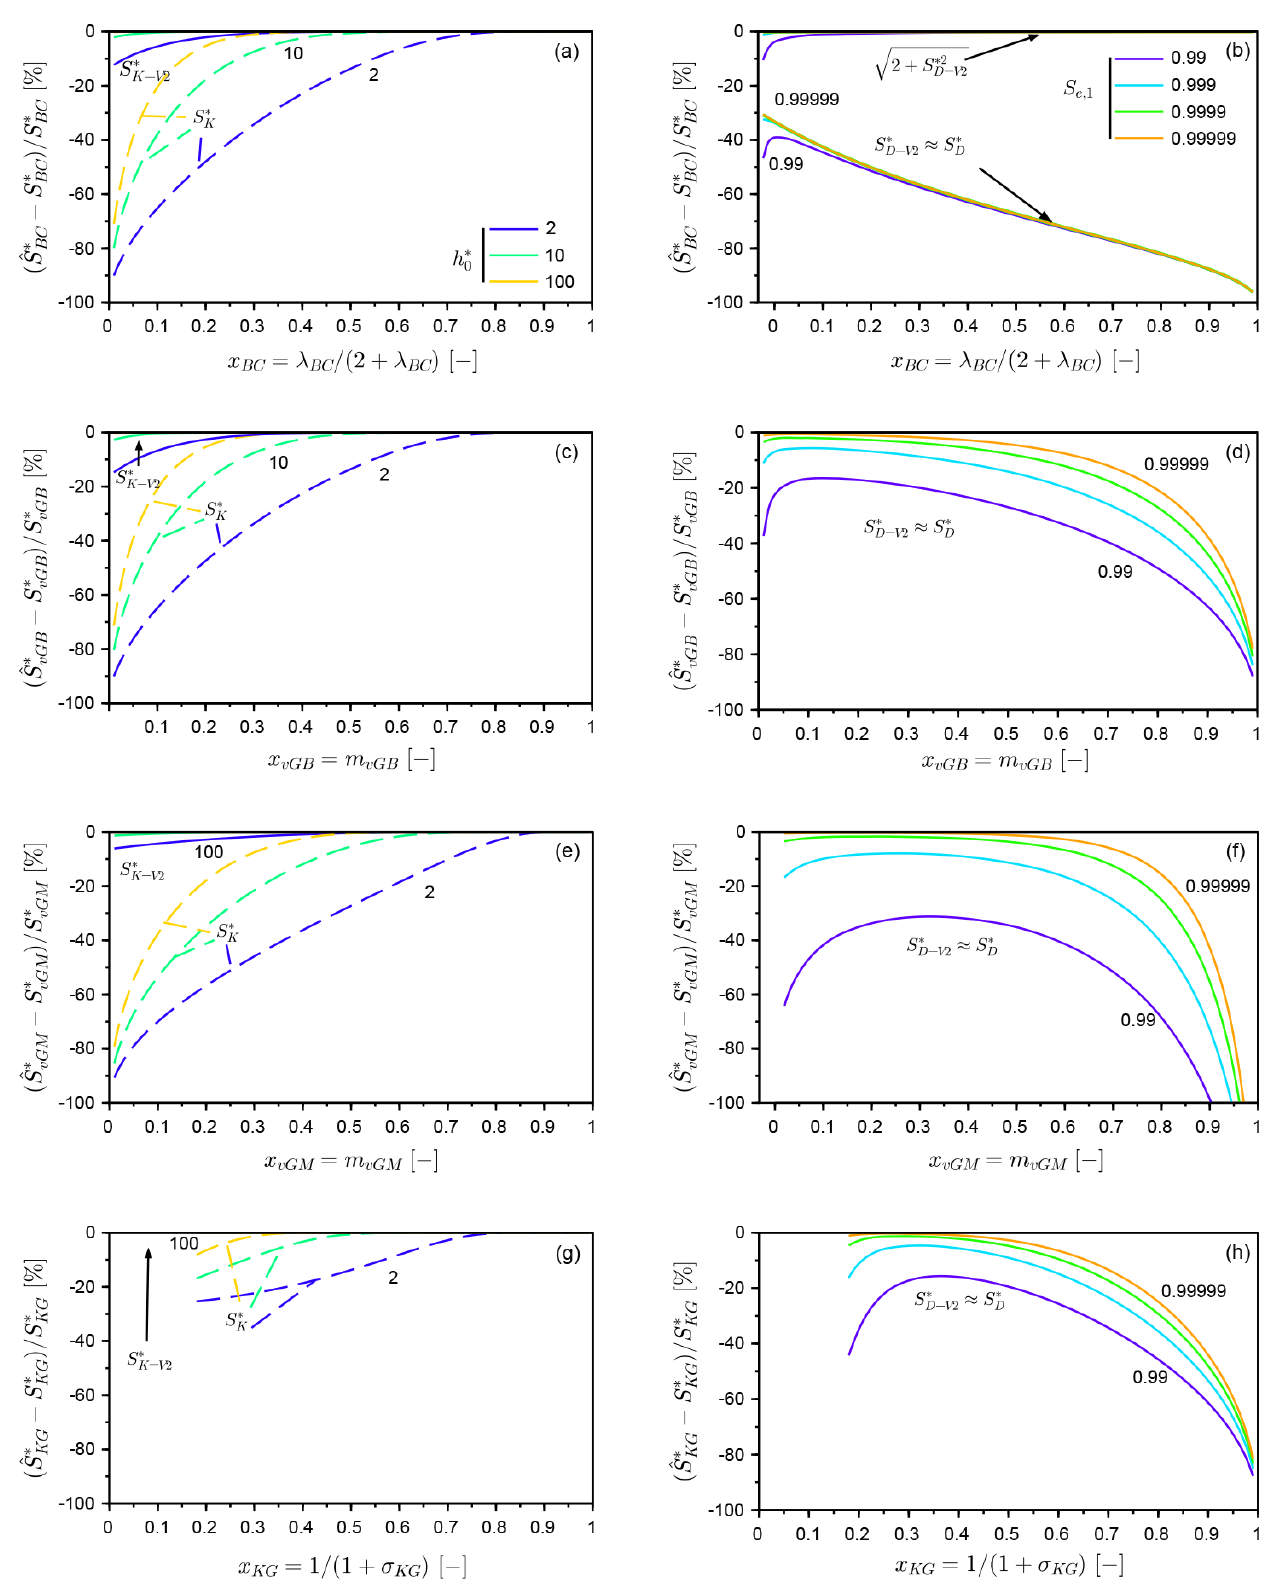
Figure 6. Relative errors of estimators S ∗ BC, vGB, vGM, and KG models, as a function of the WR shape indices.